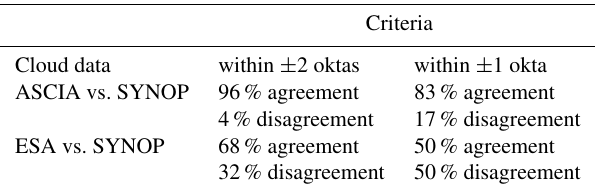
Table 4. A summary of the comparison of ASCIA and ESA cloud products with SYNOP measurements used to validate these prod-